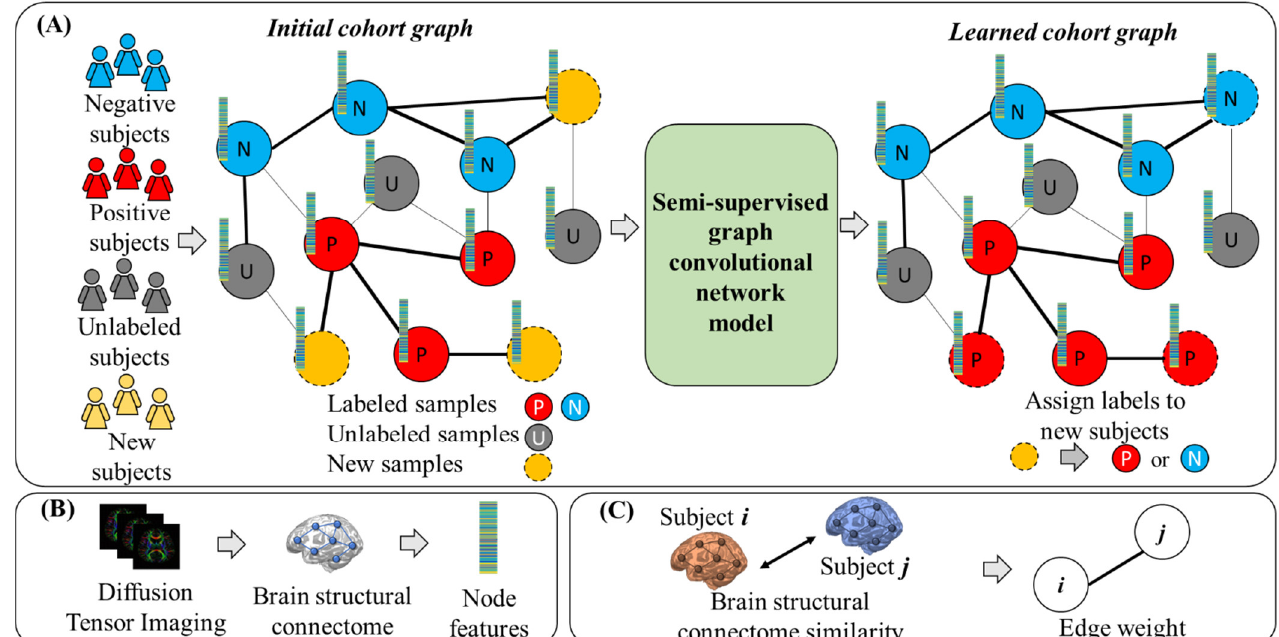
Figure 1. The proposed semi-supervised learning framework to predict motor impairment at 2 years corrected age using brain structural connectomes derived from DTI data acquired at term in very preterm infants. Given both labeled (blue and red) and unlabeled (gray) subjects ready for model learning, our task was to classify new subjects (yellow) into one of the label groups. ( A ) We constructed an initial cohort graph , including labeled subjects (positive (P) and negative (N)), unlabeled (U) subjects, and to-be-predicted new subjects. The semi-supervised GCN model learned the initial cohort graph and assigned labels (i.e., positive for high risk and negative for low risk of developing motor impairment) to new subjects in the learned cohort graph . ( B ) We used diffusion tensor imaging (DTI)-derived brain structural connectomes as node features and ( C ) the similarity between brain connectomes as edge weights between nodes.